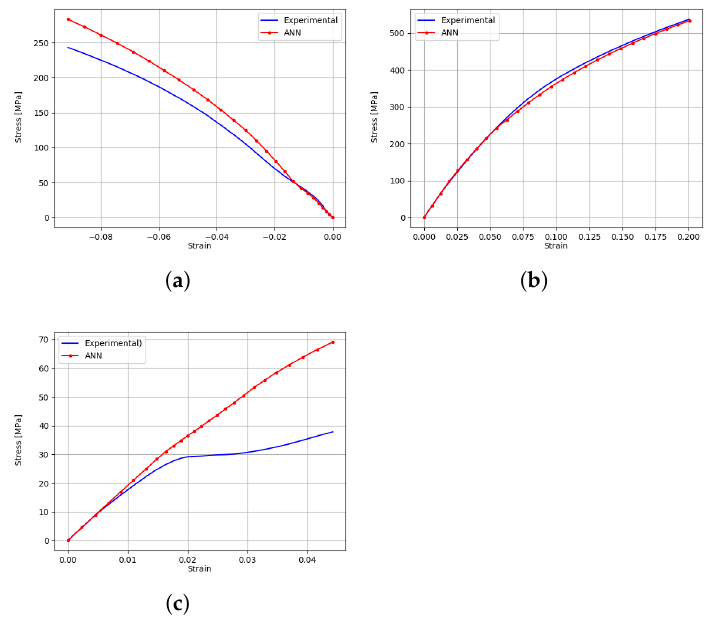
Figure 18. Stress-strain curves obtained for the selected point of the butterfly test: ( a ) σ xx − ε t xx , ( b ) σ yy − ε t yy and ( c ) τ xy − ε t xy curves. Comparison between the ANN model and (virtual) experimen- tal values [22].